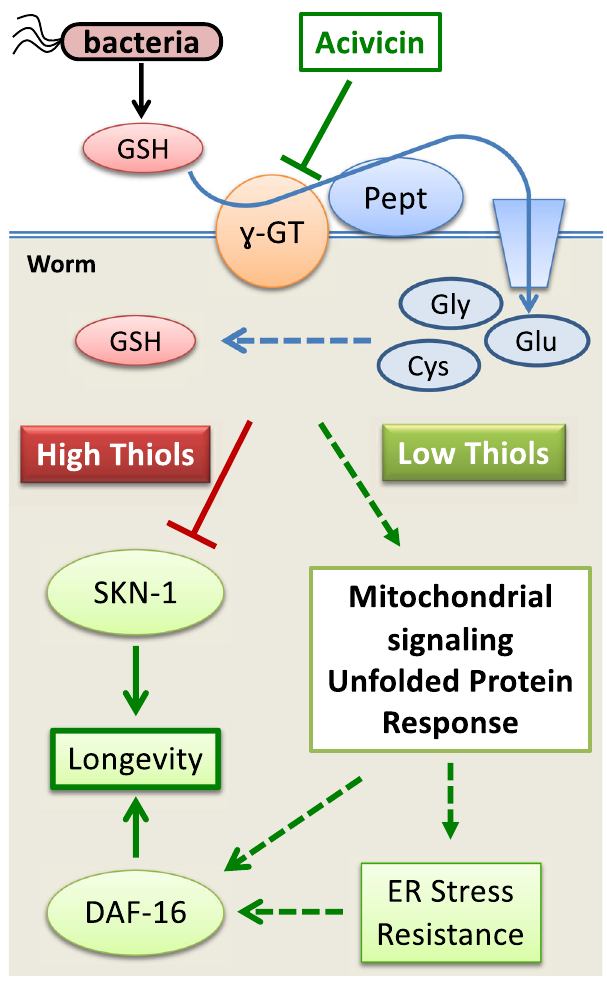
Fig. 8 The proposed mechanism of the C. elegans response to exogenous thiols. An excessive amount of GSH supplied by an E. coli diet leads to accumulation of a higher level of endogenous thiols (including GSH and Cys), which perturbs global gene expression, including the inhibition of SKN-1-mediated transcription, and accelerates aging. Acivicin restricts dietary GSH intake, favors an increased ROS production in mitochondria, which triggers the UPR-like response, enhances proteotoxic stress resistance, ultimately leading to an extended